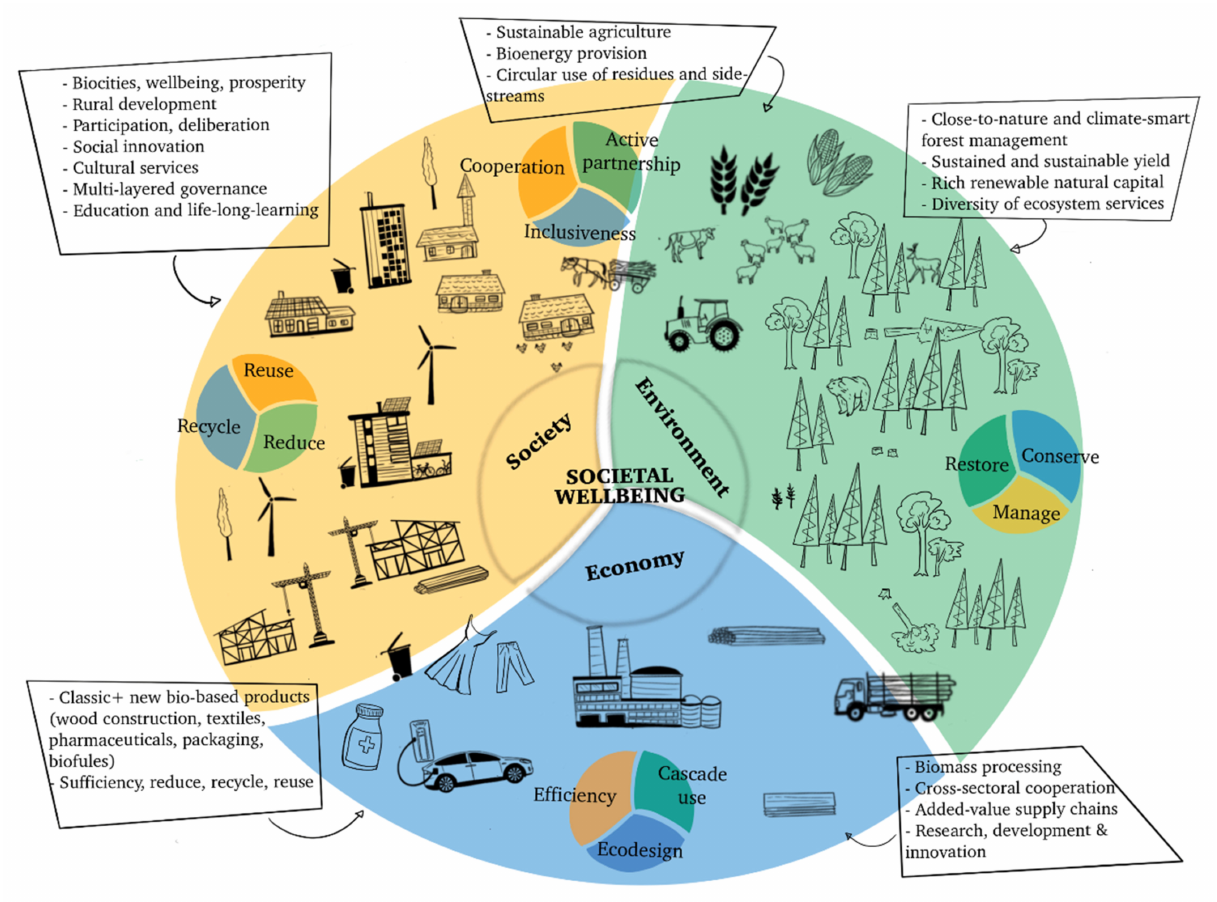
Figure 1. Romania’s Circular Forest-Bioeconomy of Wellbeing. Adapted after